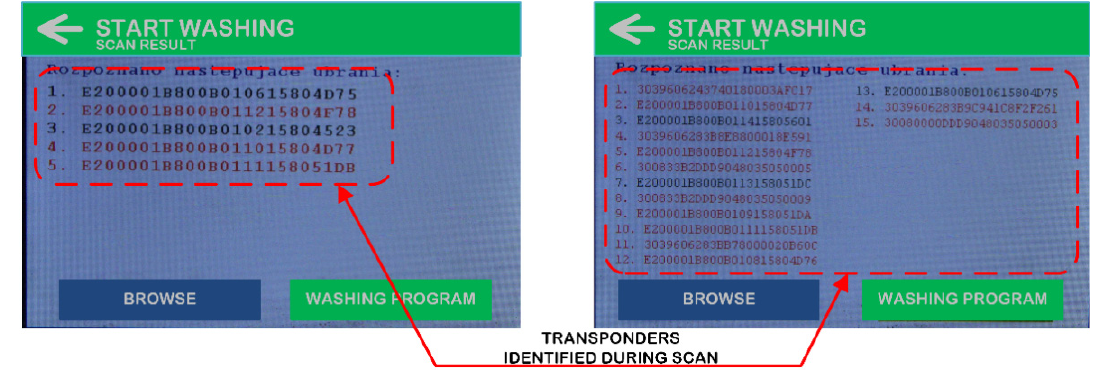
Figure A2. list of read transponders. Figure A2. List of read